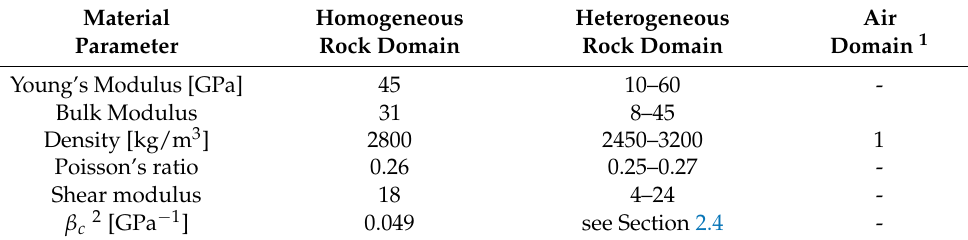
Table 1. Material property parameters used for the